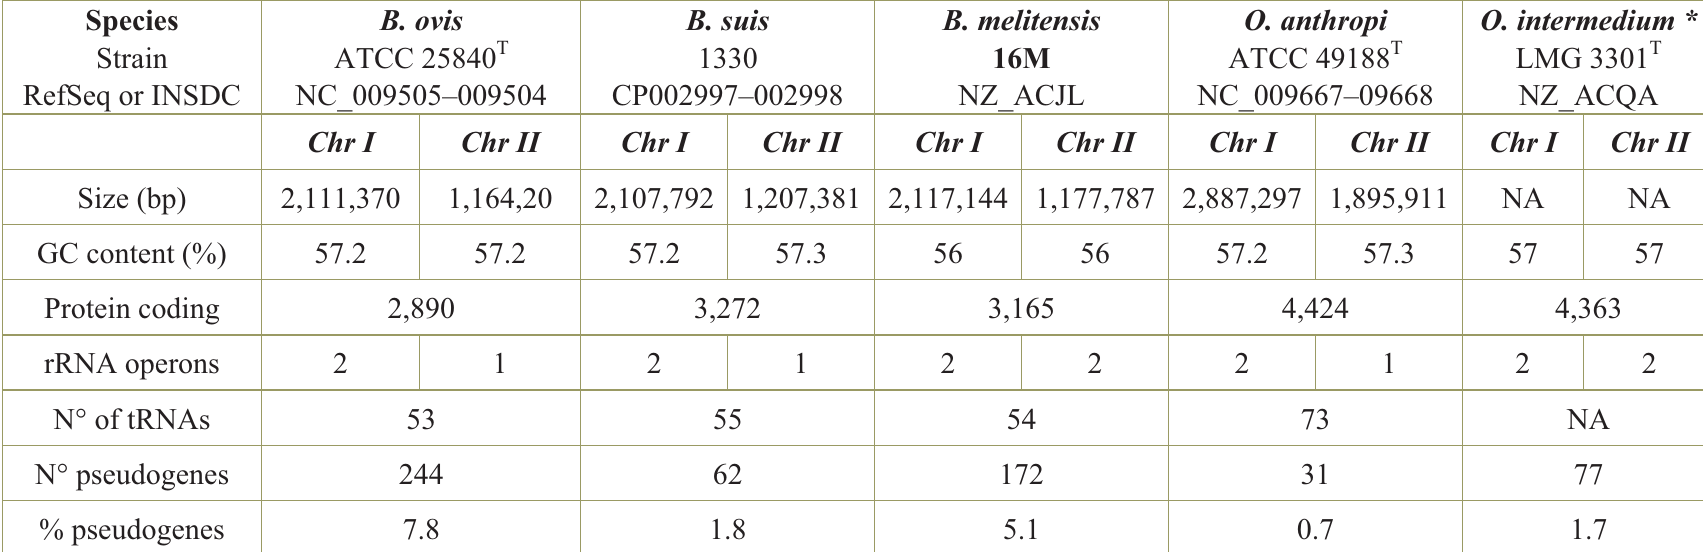
Table 3. Features of selected Brucellaceae genomes obtained from NCBI and PATRIC